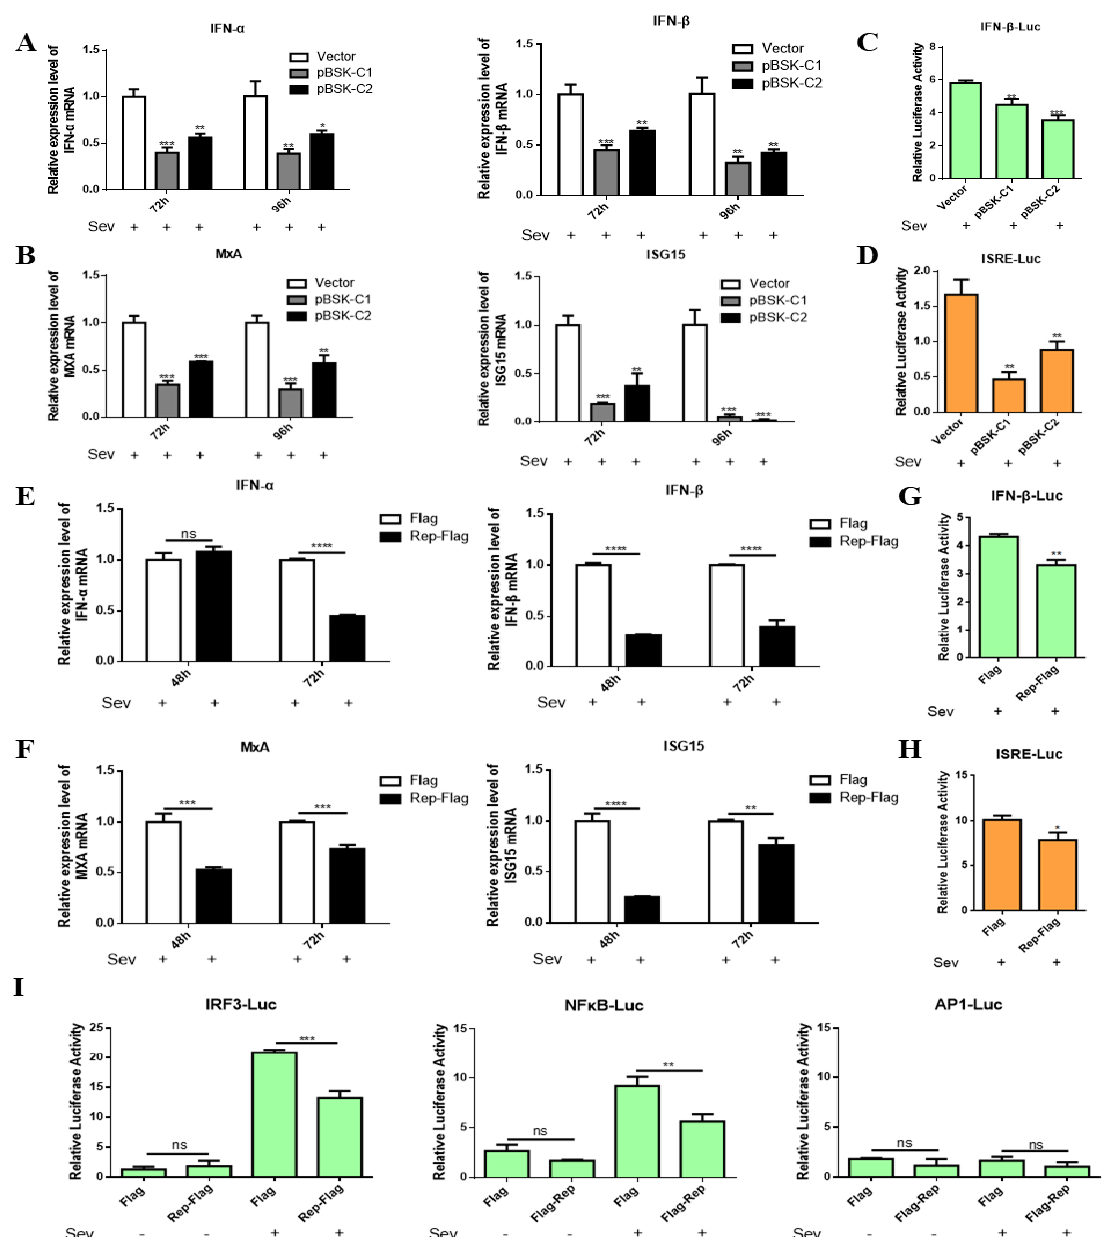
Figure 3. CanineCV and Rep inhibit IFN-I and ISG expression. F81 cells were transfected with different plasmids, total RNA was extracted from the cells at the indicated time points, and the mRNA levels of IFN- α , IFN- β ( A , E ), MxA and ISG15 ( B , F ) were measured by qPCR. In the dual luciferase assay, F81 cells were transfected with different plasmids for 24 h, inoculated with SeV and incubated for another 12 h, and lysed for determination of luciferase activity ( C , D , G – I ). CanineCV and the Rep protein inhibited SeV-activated IFN- α , IFN- β , MxA, and ISG15 expression at the mRNA level. Second, the results of the dual luciferase assay showed that CanineCV and the Rep protein blocked the activation of the IFN- β and ISRE promoters. Finally, the Rep protein blocked the interferon signaling pathway through the IRF3 and NF κ B pathways. * p < 0.05, ** p < 0.01, *** p < 0.001, **** p < 0.0001 compared with the empty vector transfection